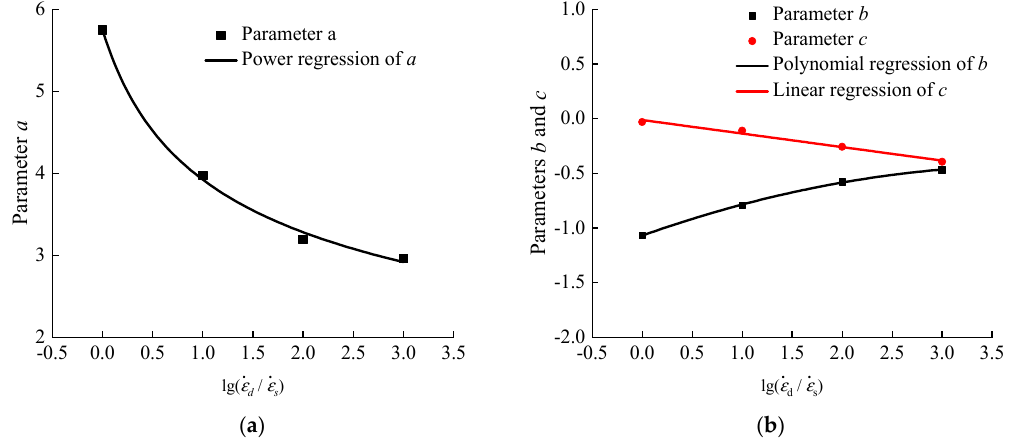
Figure 11. Relation between temperature effect parameters and strain rate. ( a ) parameter a ; ( b ) Figure11. Relationbetweentemperatureeffectparametersandstrainrate. ( a )parameter a ; ( b )parameters parameters b and c . b and c